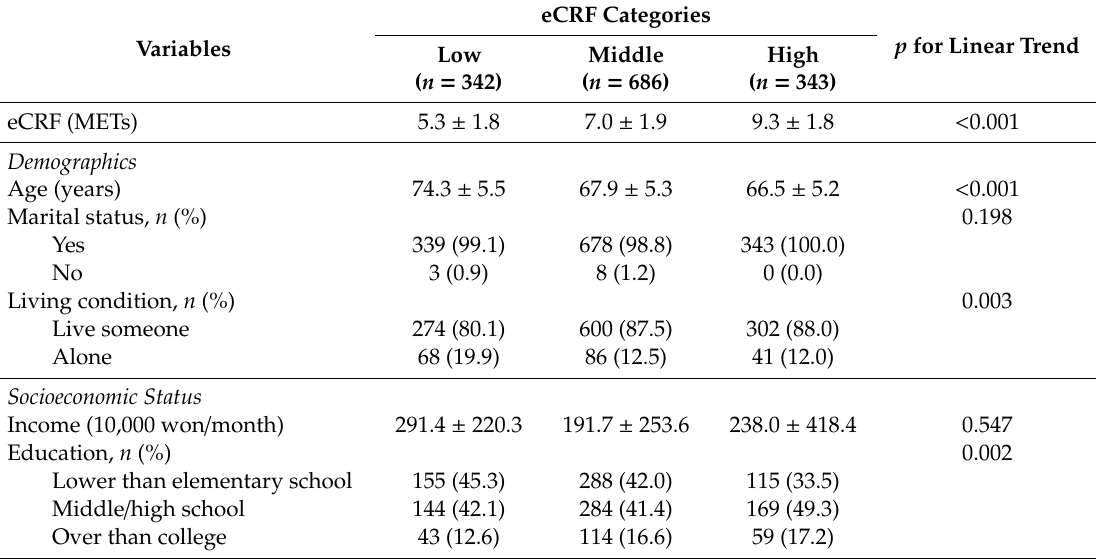
Table 3. Descriptive statistics of measured parameters according to eCRF categories (Mean ±